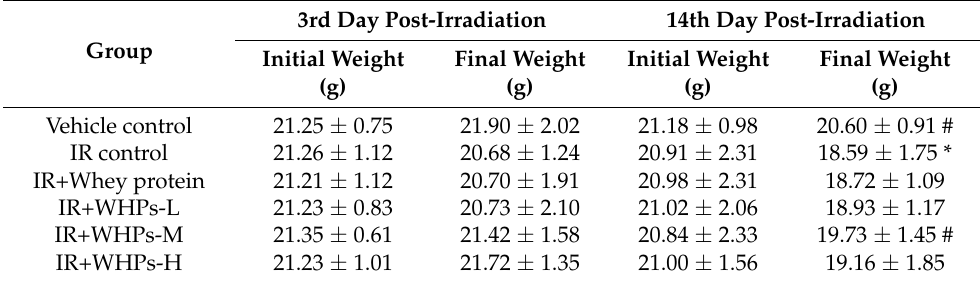
Table 3. Effects of WHPs on body weight in irradiated mice ( n = 12, x ± s).